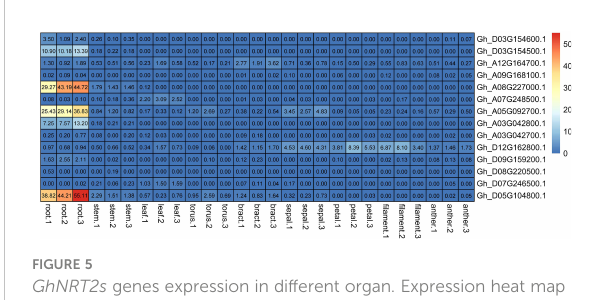
FIGURE 5 GhNRT2s genes expression in different organ. Expression heat map of GhNRT2s family genes in different organ transcriptomes. All data were downloaded in cottonFGD (https://cottonfgd.net/, on October 18, 2022).